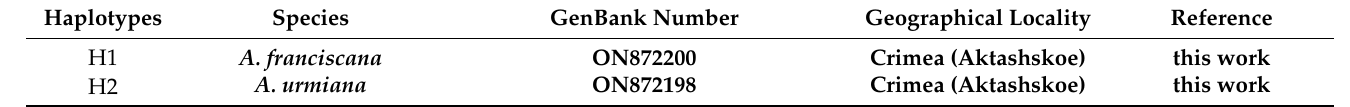
Table A1. The list of COI haplotypes for all Artemia populations analyzed in the present study (Figure 2). The Crimea populations studied in this work are highlighted in